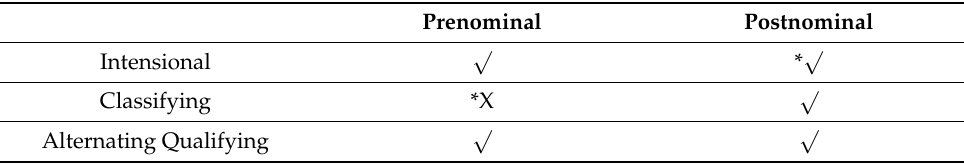
Table 2. Convergence predictions according to adjective type and position.